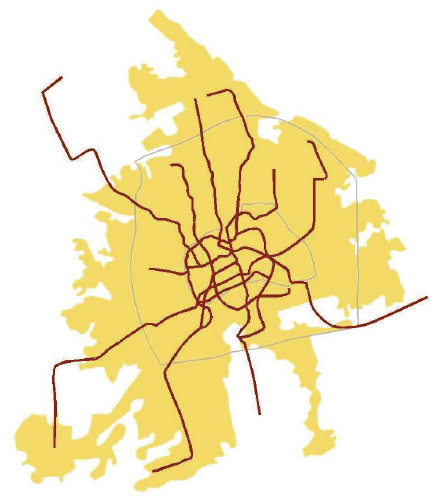
Figure 2: Shanghai rail-based urban mass transit (cid:6) in red (cid:7) and inner- and outside ring streets (cid:6) in grey (cid:7) as well as urban constructed area (cid:6) in yellow (cid:7)